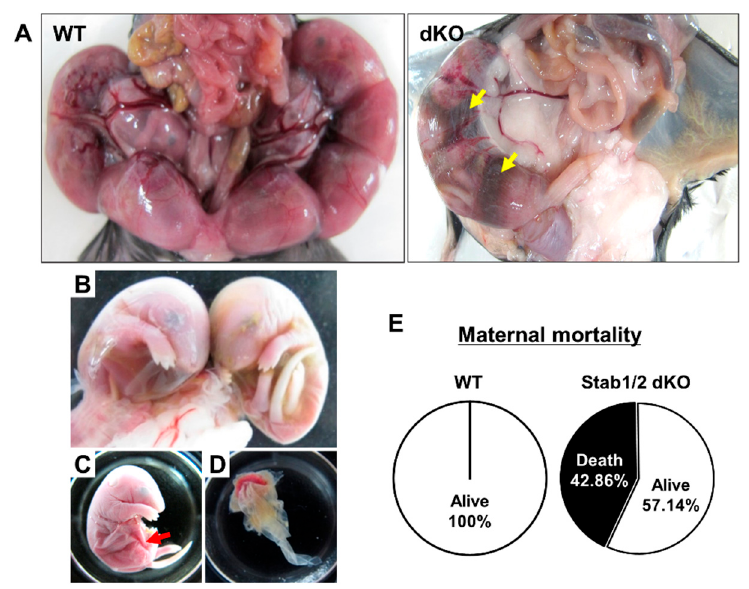
Figure 3. Embryos from pregnant Stab1 / 2 dKO mice at E17.5. ( A ) Uterine horns with embryos in WT and Stab1 / 2 dKO mice. Yellow arrows in Stab1 / 2 dKO indicate blood within the uterine horns. ( B ) Embryos isolated from the uterine horns of a Stab1 / 2 dKO female mouse. ( C ) Embryo and ( D ) placenta from a Stab1 / 2 dKO female mouse. The fetus only maintained the outer shape in the lower body and the fetal interior was degraded near the umbilical cord. Red arrow in ( C ) denotes abnormal abdomen in an embryo. ( E ) Maternal mortality of Stab1 / 2 dKO mice at the first delivery. n = 7.